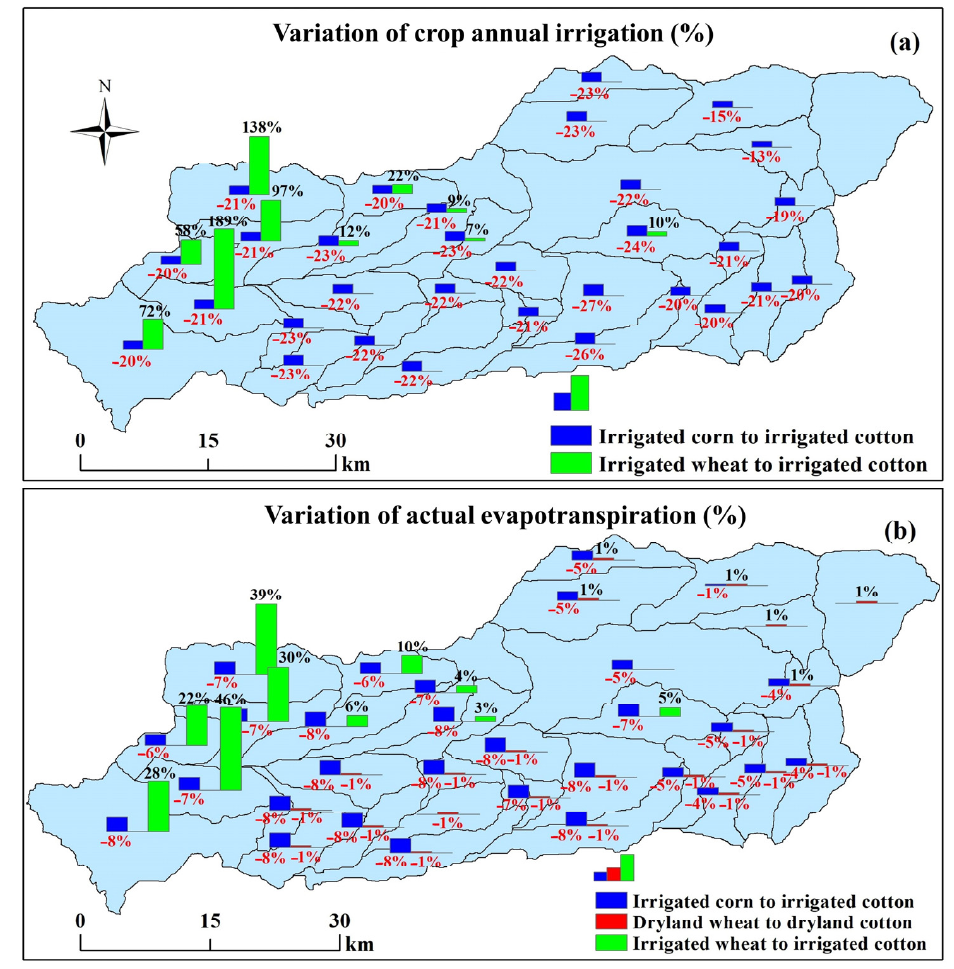
Figure 2. The spatial distribution of simulated annual irrigation and ET a under cotton land-use change scenarios in the Palo Duro watershed.